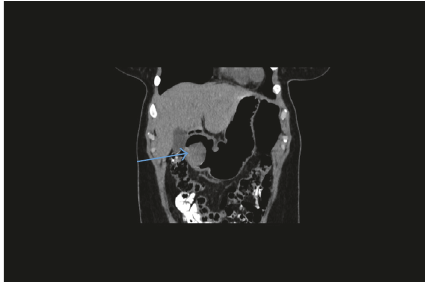
Figure 2: Coronal section of CT scan of abdomen, showing gastric mass near pylorus with no local invasion outside the gastric mucosa.